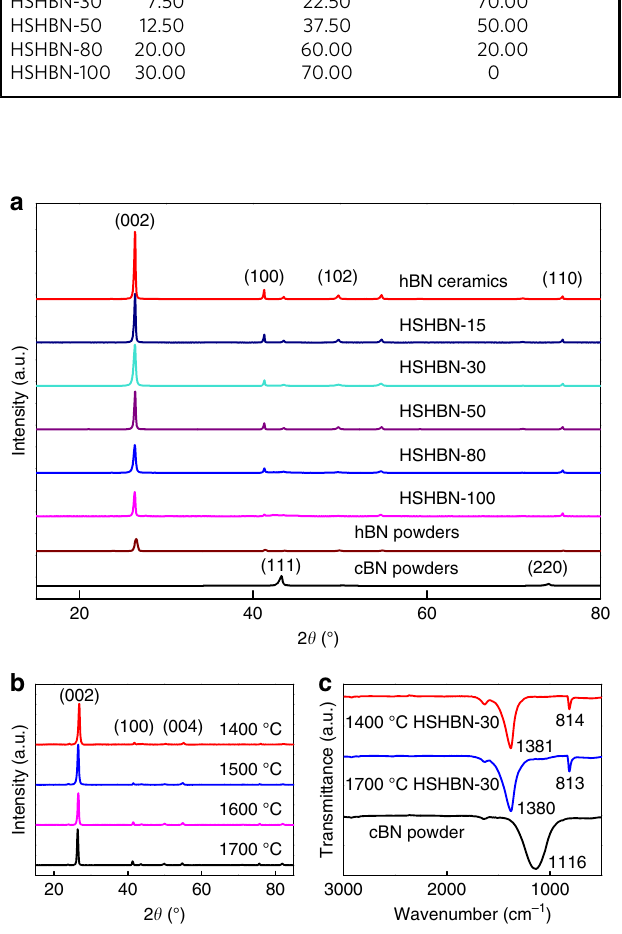
Fig. 2 Characterization of phase evolution in the as-prepared samples. XRD patterns of the cBN and hBN precursor powders, pure hBN ceramics and HSHBN samples sintered at 1700 °C ( a ); XRD patterns of HSHBN-30 with sintering temperatures of 1400 °C – 1700 °C ( b ); Fourier transform infrared spectroscopy (FTIR) spectra of cBN powder, and HSHBN-30 samples sintered at 1400 °C and 1700 °C ( c ) NATURE COMMUNICATIONS| (2019) 10:854